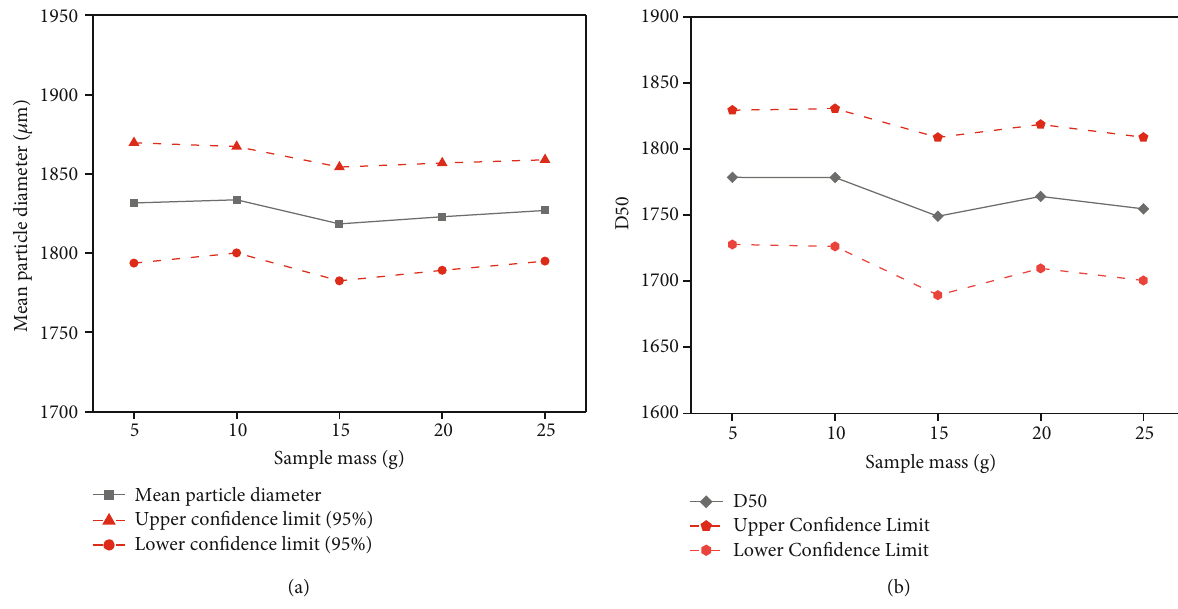
Figure 5: The relationship between the 95% con fi dence interval width and the sample mass (mean diameter (a) and the median diameter D50 (b); the distance between the upper and lower curves represents the width of the 95% con fi dence interval).